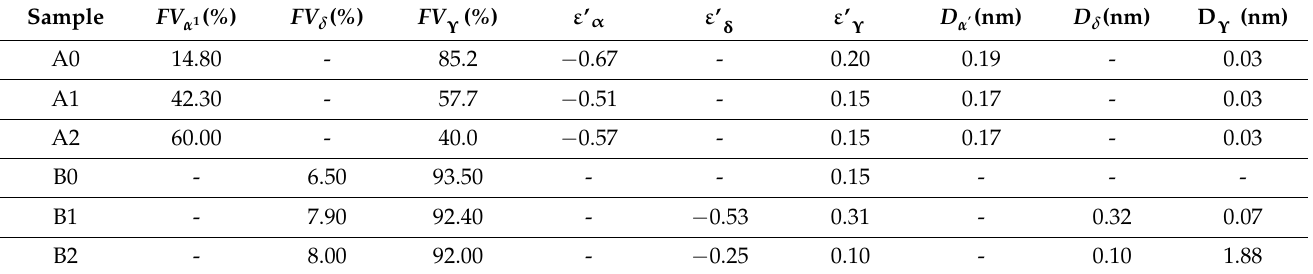
Figure 1. Diffractograms obtained for the A0 ( a ), A1 ( b ), A2 ( c ), B0 ( d ), B1 ( e ), and B2 ( f ) samples. Table 5 summarizes the volumetric fraction values for all detected phases as well as the microstrain ( ε ’) and crystalline domain size (D) values for each phase in each of the studied samples. Table 5. Values of volumetric fraction, microstrain, and size of the crystalline domain obtained for all samples.